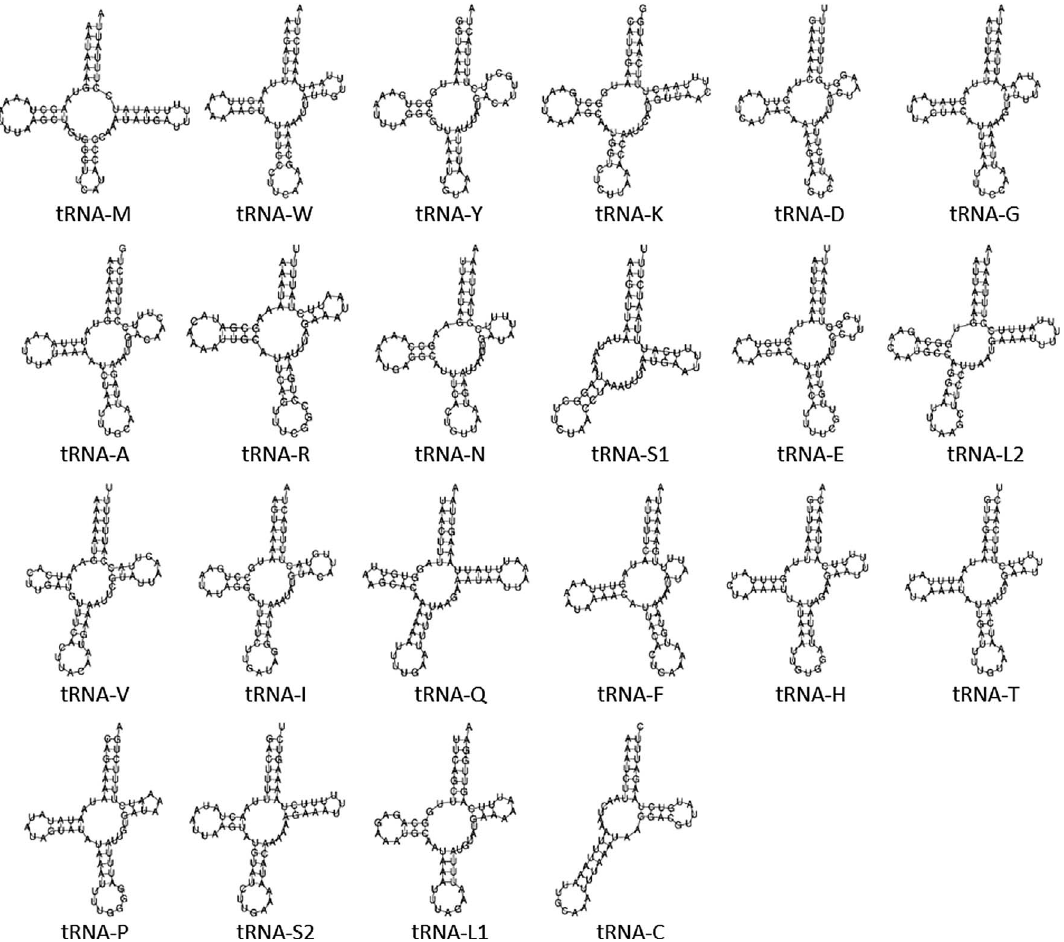
Figure 2. Predicted secondary structure of the mitochondrial tRNA genes of Dermacentor ( Indocentor ) auratus obtained using the Vienna RNA Websuite